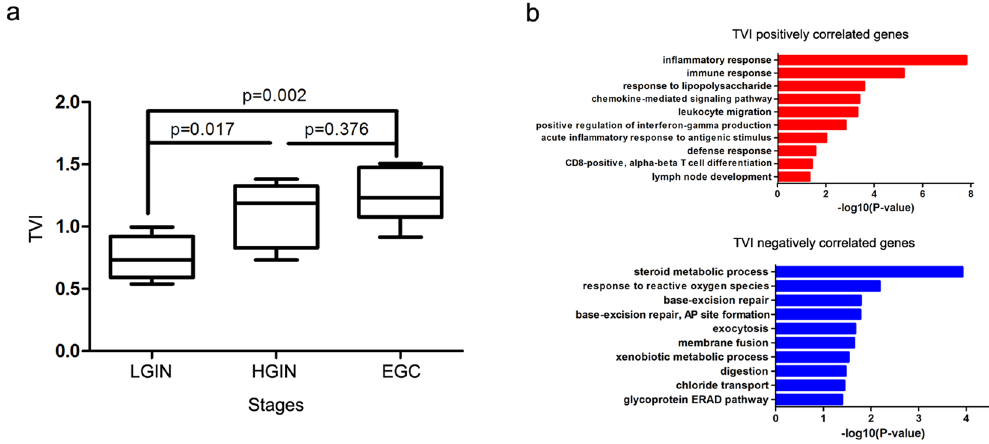
Figure 5. Identification of genes correlated with TVI. ( a ) The TVI gradually increased during gastric tumourigenesis. One-way ANOVA and Tukey’s post hoc multiple comparison test, p < 0.05. ( b ) Representative GO biological process terms for TVI-correlated